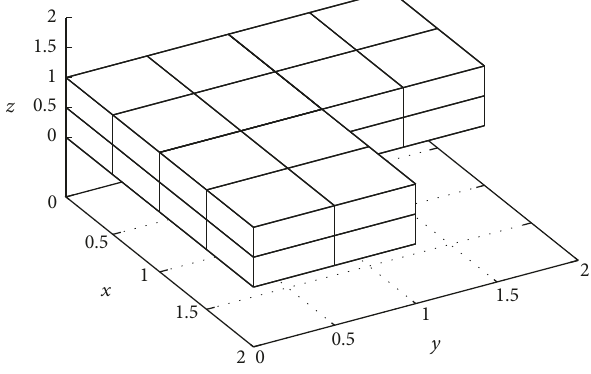
Figure 16: Cylinder: 𝑝 -convergence of